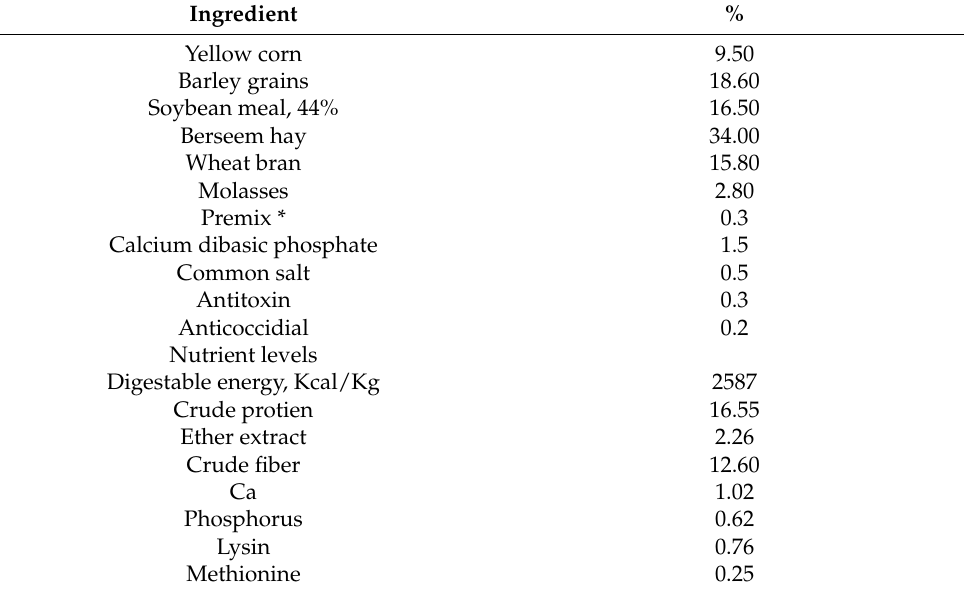
Table 1. Feed ingredients and nutrition levels of the control experimental diet. Ingredient % Yellow